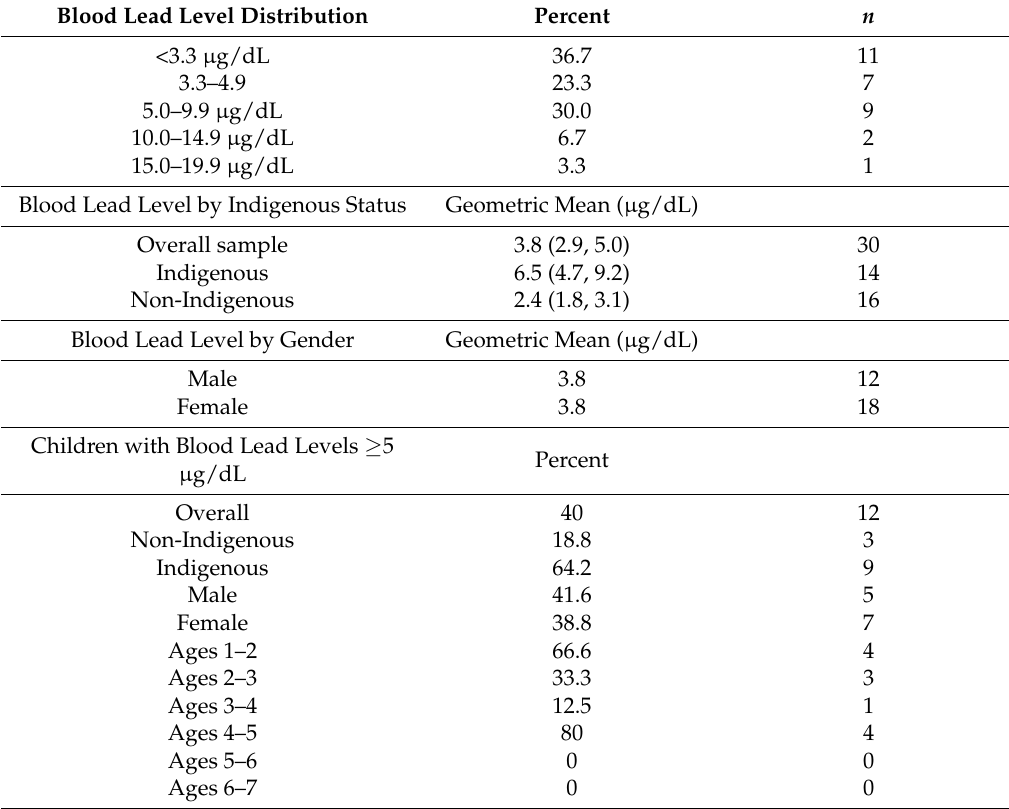
Table 3. Blood lead level